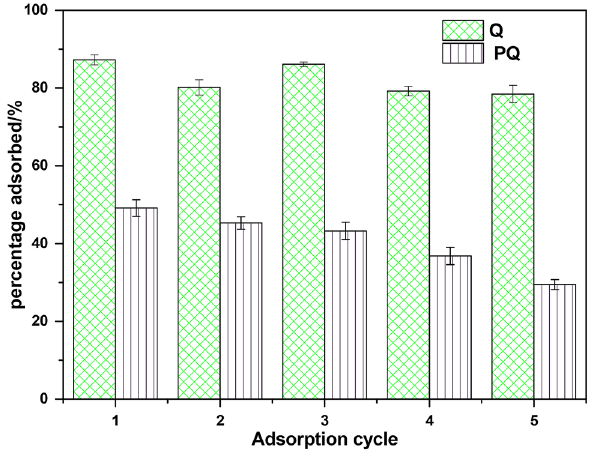
Figure 12. The performance of PQ and Q over five successive adsorption–desorption